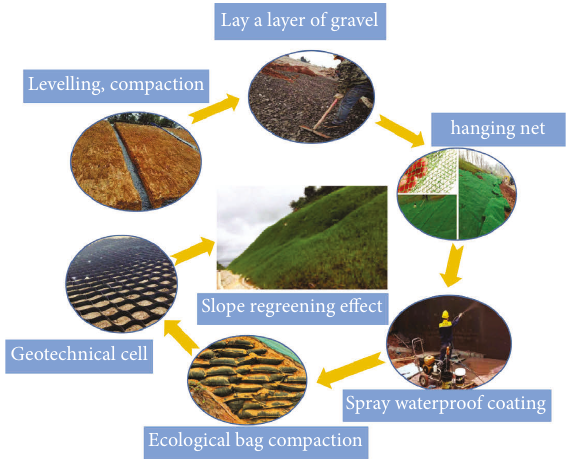
Figure 19: Implementation process of the new